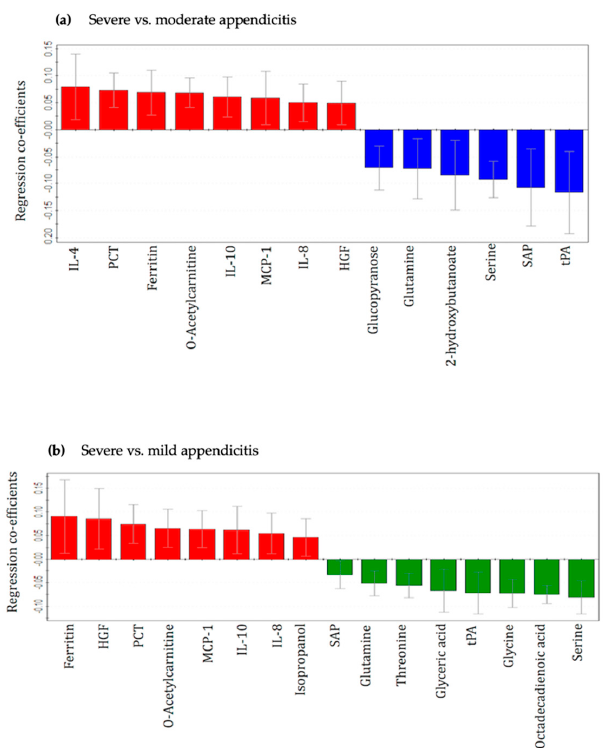
Figure 4. Regression coefficient plots for the statistically significant ( p < 0.05) metabolites and inflammatory mediators distinguishing children with ( a ) severe vs. moderate appendicitis and ( b ) severe vs. mild appendicitis. Red bars with positive coefficient values represent increased concentrations in the severe appendicitis children, blue bars and green bars with negative values represent reduced concentration in the severe appendicitis patients, compared with moderate and mild